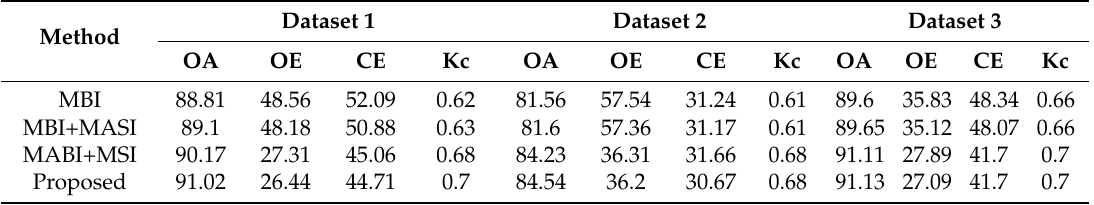
Table 8. Accuracy of the building detection results with different shadow